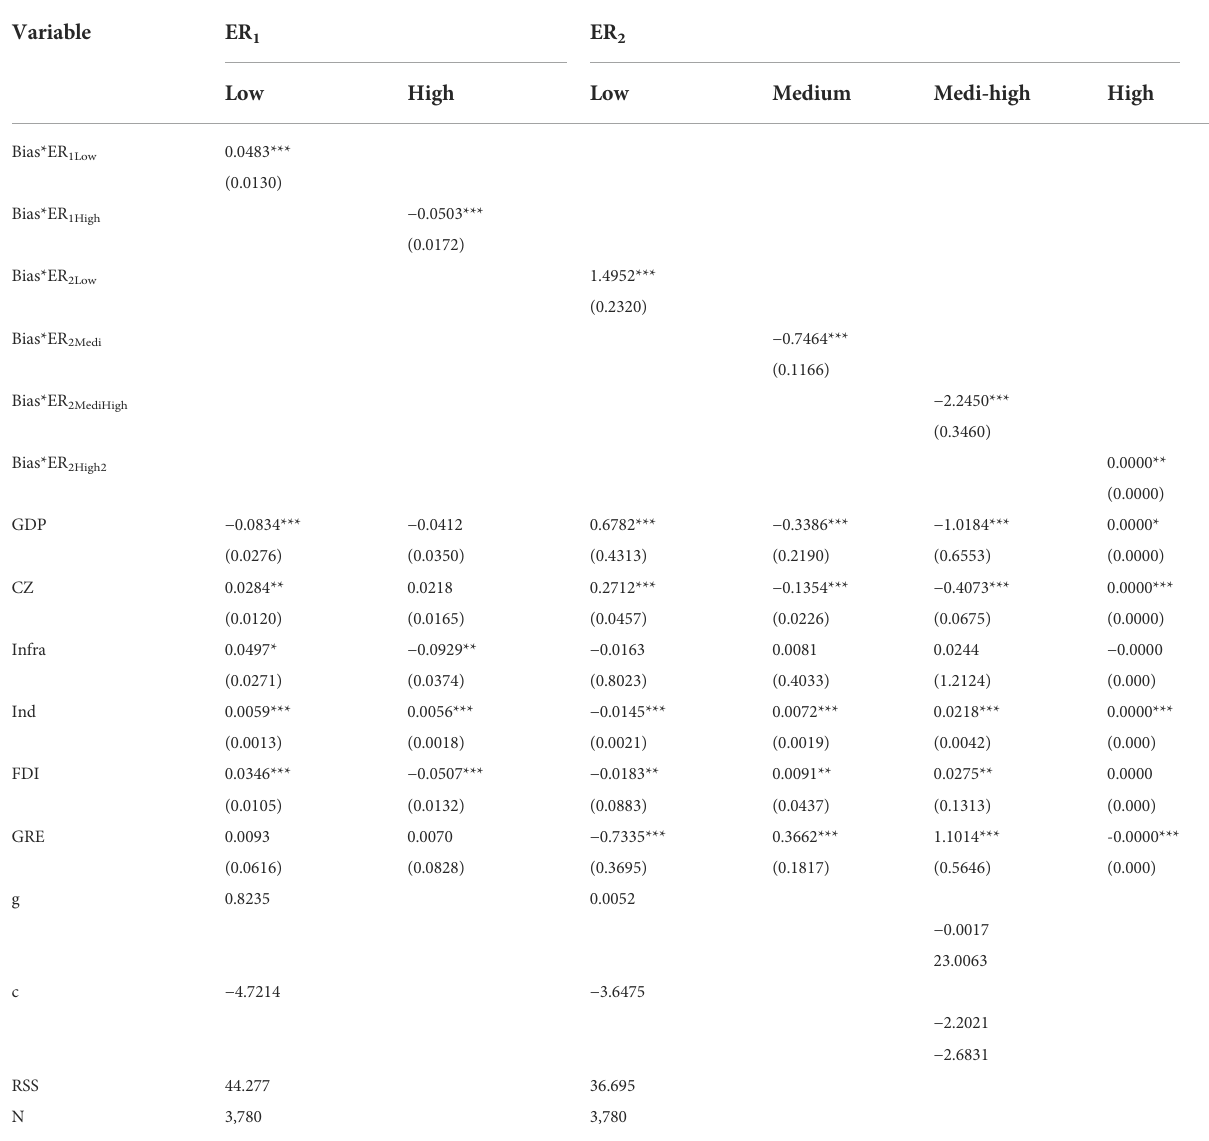
TABLE 13 PSTR model estimation